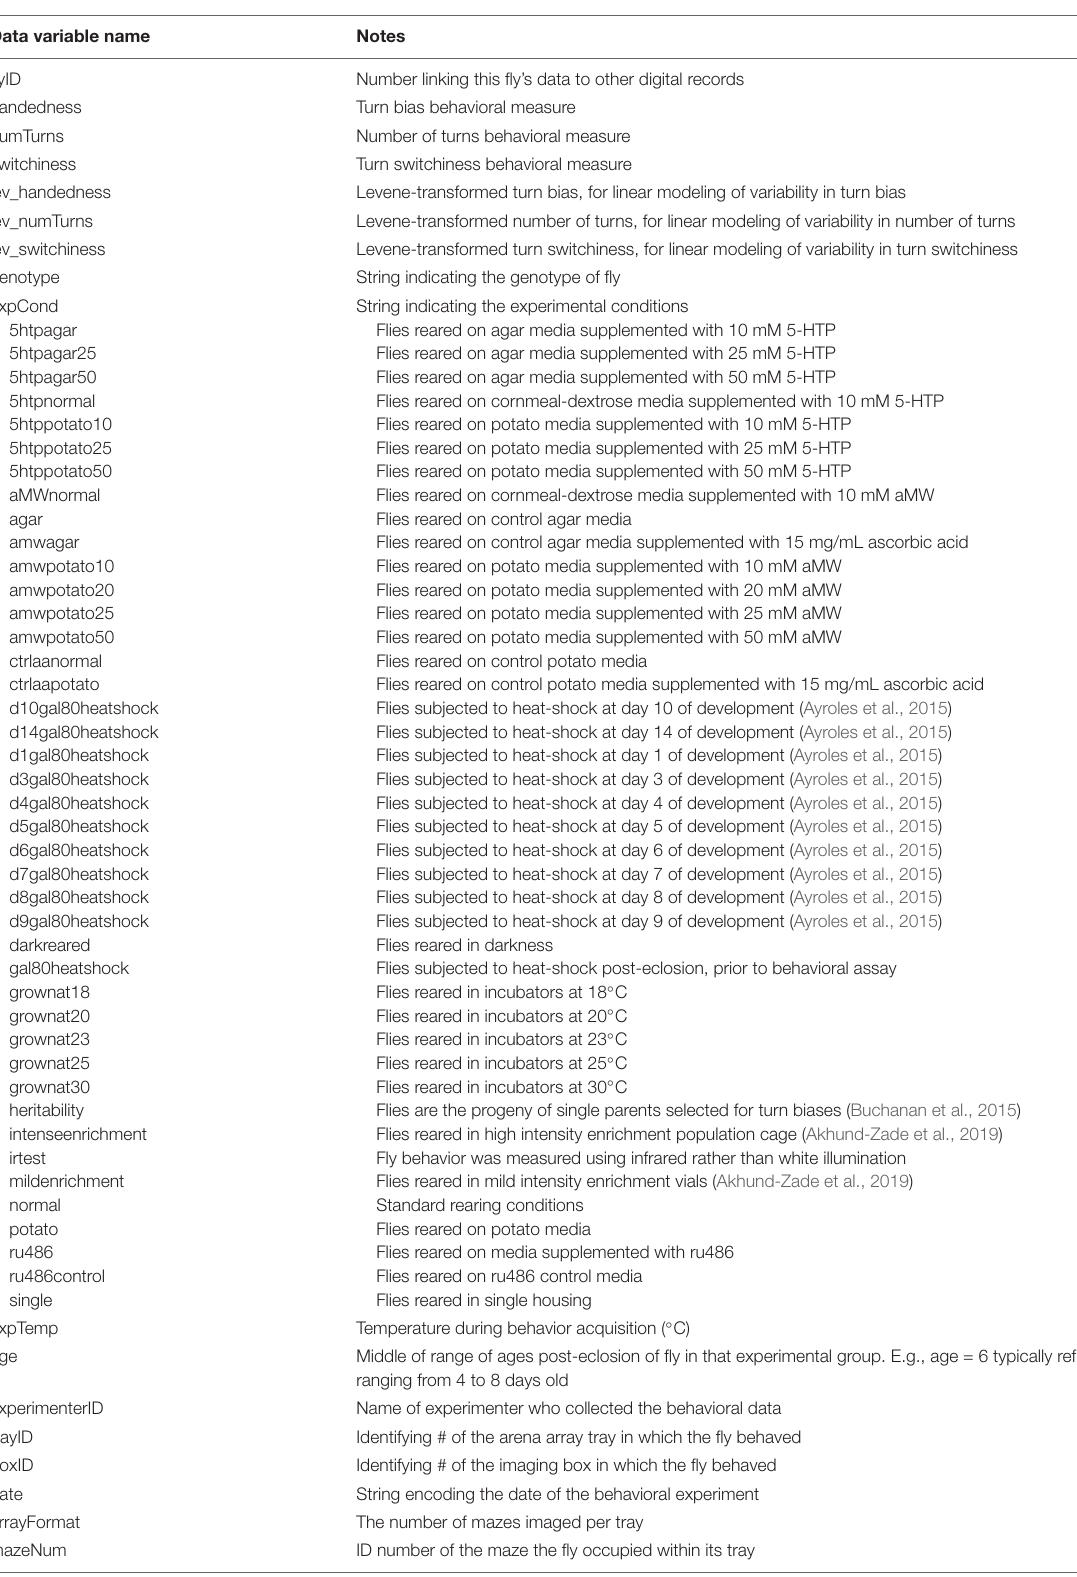
TABLE 1 | Y-maze data set